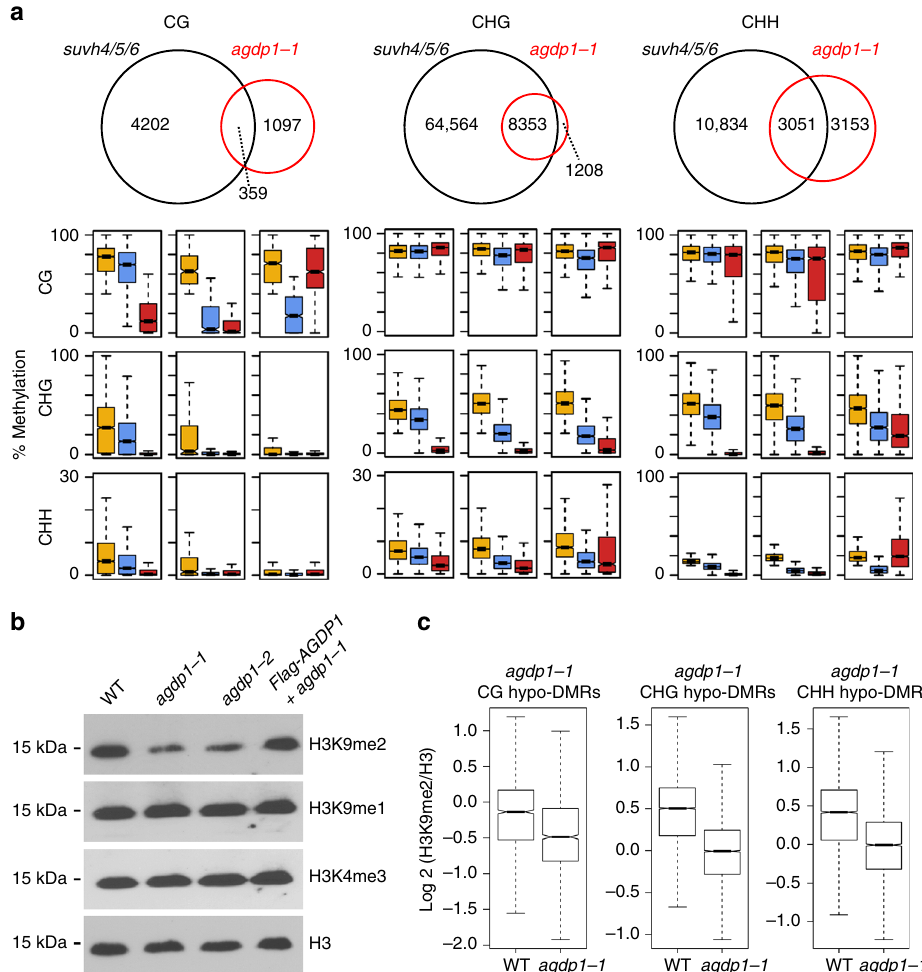
Fig. 5 agdp1 affects H3K9 dimethylation and suvh4/5/6 -dependent CHG and CHH methylation. a Venn diagrams showing the overlap of hypo-DMRs between agdp1 and suvh4/5/6 in CG, CHG, and CHH contexts. Box plots represent CG, CHG, and CHH methylation levels of overlapping or unique hypo- DMRs in the upper Venn diagrams. Yellow, blue, and red boxes indicate DNA methylation levels in the wild-type, agdp1-1 , and suvh4/5/6 , respectively. b Western blot analysis of H3 lysine methylation status in wild-type Col-0 plants and in agdp1-1 , agdp1-2 , and Flag-AGDP1 transgenic plants in the agdp1-1 mutant background with the antibodies speci fi ed on the right. c Box plots of levels of H3K9me2 relative to H3 in agdp1-1 CG, CHG, and CHH hypo-DMRs. The y axis represents the ChIP-seq read density normalized by